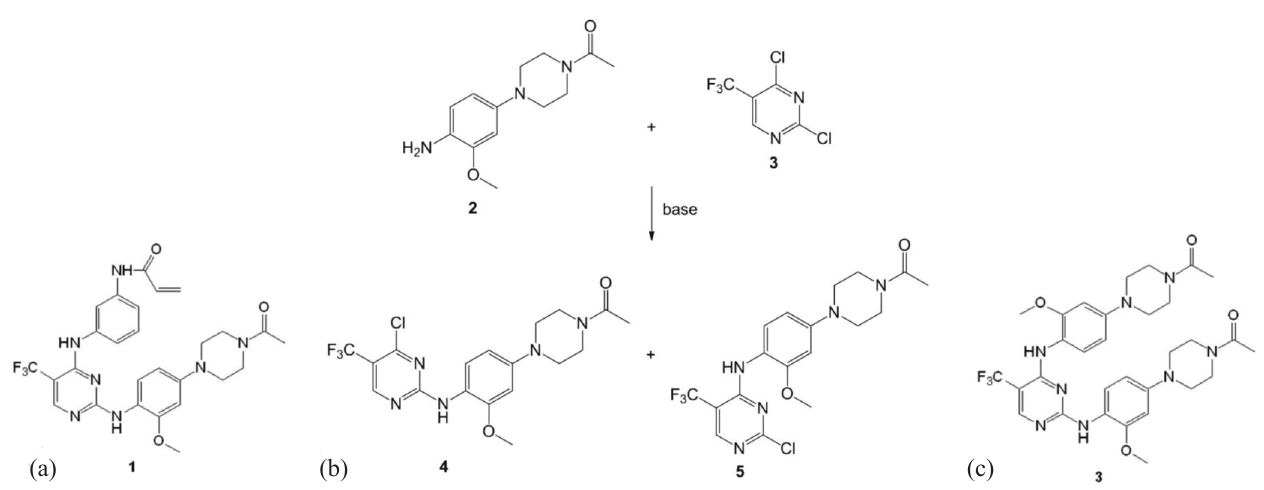
Fig. 1 – Chemical structure of: a) Rociletinib 1 , b) regioselective nucleophilic aromatic substitution of C-2 chlorine at pyrimidine molecule 3 with 2 to give an amine 4 as major product and amine 5 as minor product, and c) di-substituted impurity